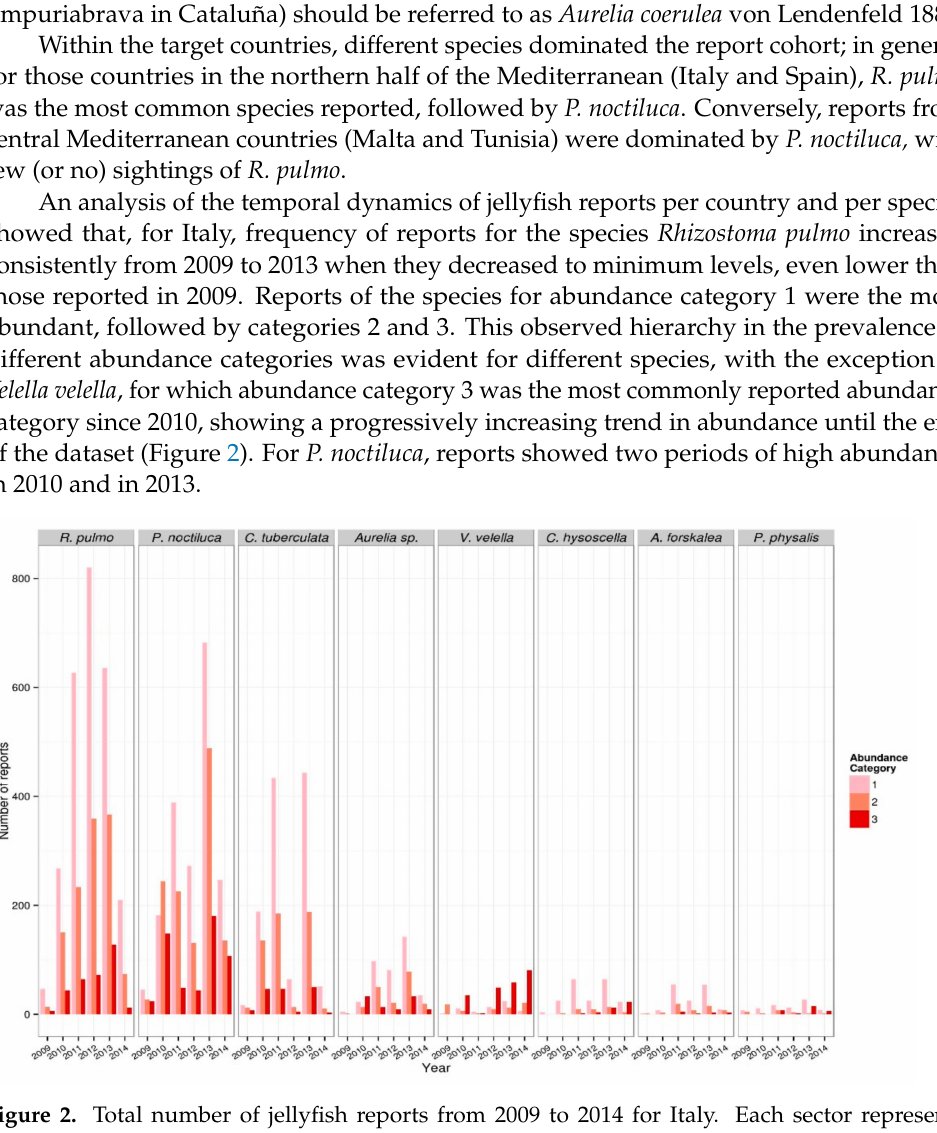
Figure 2. Total number of jellyfish reports from 2009 to 2014 for Italy. Each sector represents a different species, and the color scale represents different abundance categories (darker colors meaning higher